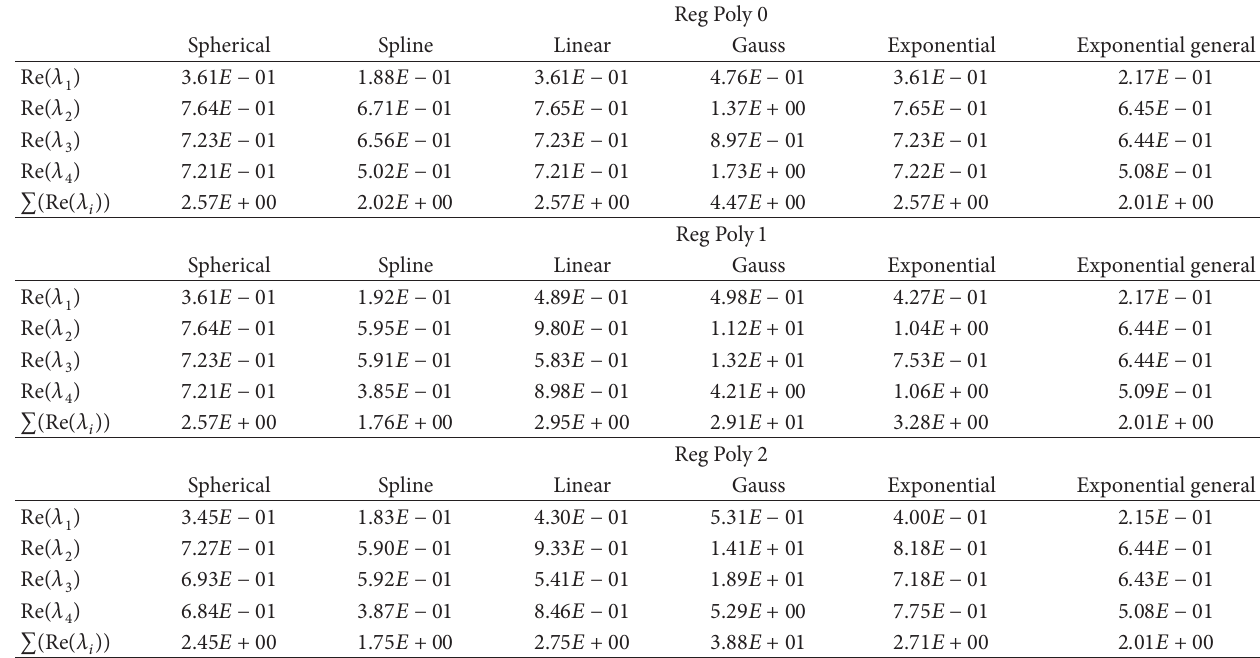
Table 7: Configuration 2: quadratic mean of the absolute error on real parts of eigenvalues for different regression and correlation kriging functions.